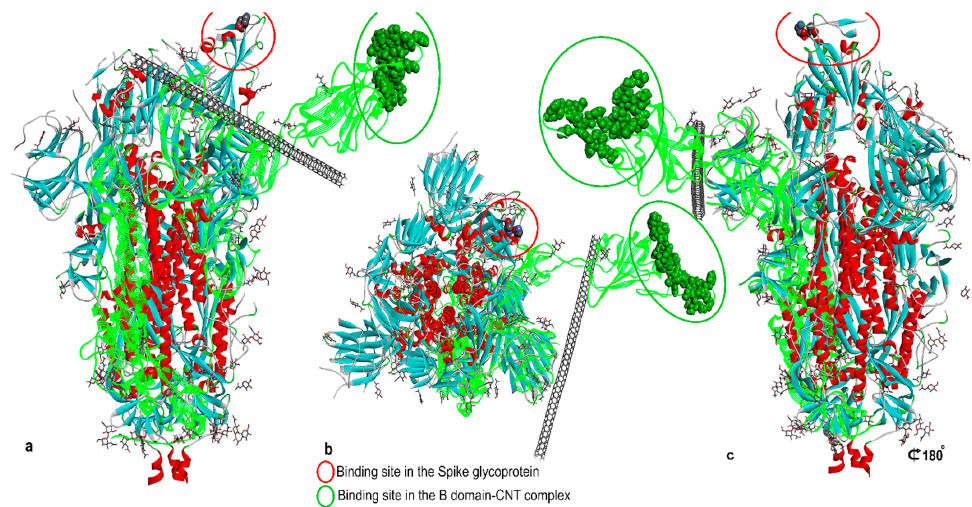
Figure 12. ( a – c ) MD simulation outcomes showing the evolution of the interactions between SWCNTs and SARS-CoV-2 spike glycoprotein. The green chain corresponds to the B domain of the spike glycoprotein simulated in the presence of SWCNTs, whereas the blue–red one is the spike glycoprotein (PDB ID: 6VYB). Reprinted from Computers in Biology and Medicine , Vol 136, Jomhori et al. Tracking the interaction between single-wall carbon nanotube and SARS-Cov-2 spike glycoprotein: A molecular dynamics simulations study, Art. N. 104692, Copyright (2021) [169], with permission from